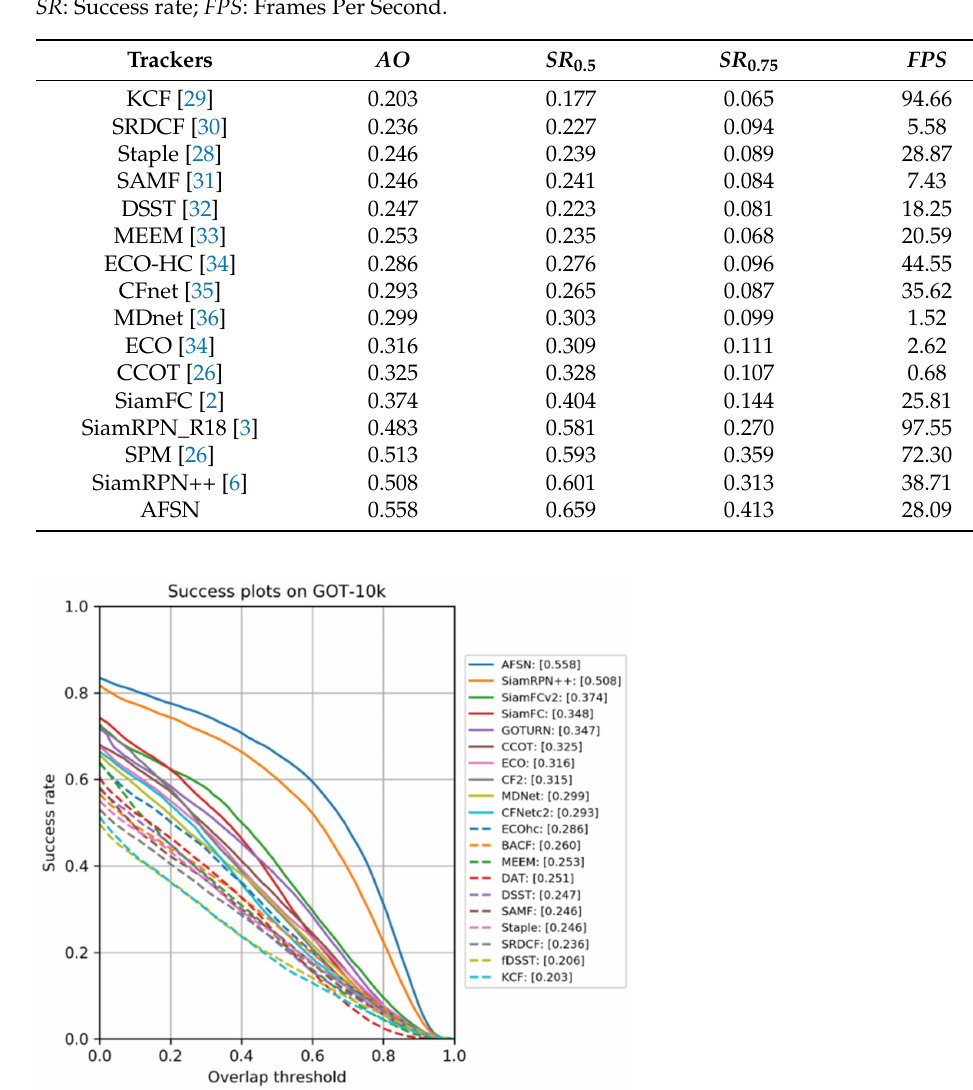
Table 1. Comparisons on GOT-10k (Generic Object Tracking Benchmark). KCF: Kernelized Correla-